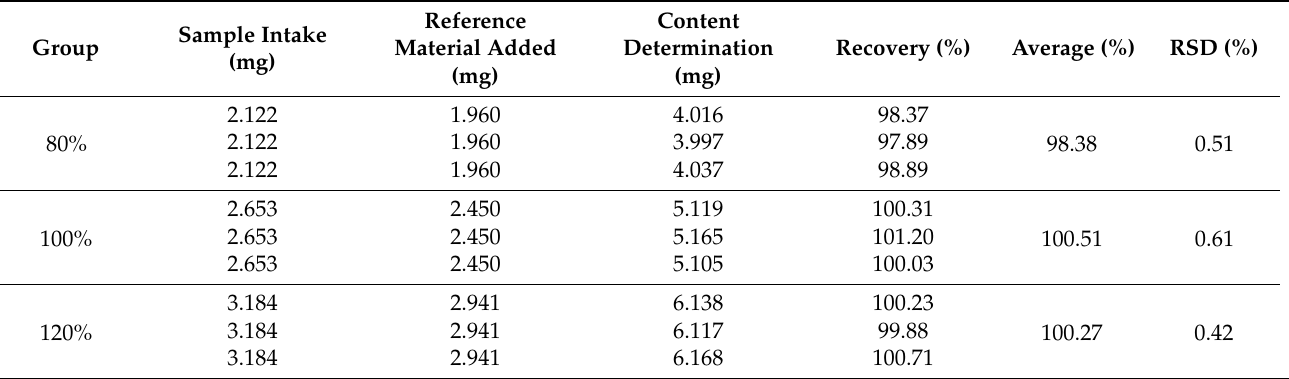
Table 5. Recovery of the developed assay ( n =